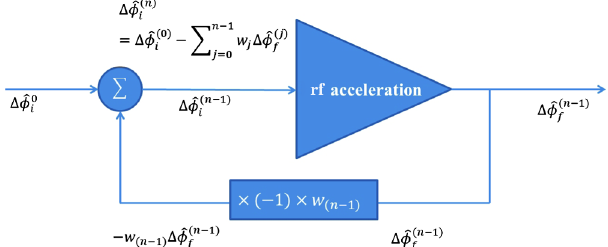
FIG. 7. An iteration loop to obtain the optimal injection phase for electrons at the cathode. The initial phase spread of electrons is iteratively modified by n times to achieve an ideal final phase ˆ ϕ ð n Þ 0 g . spread Δ f ¼ f